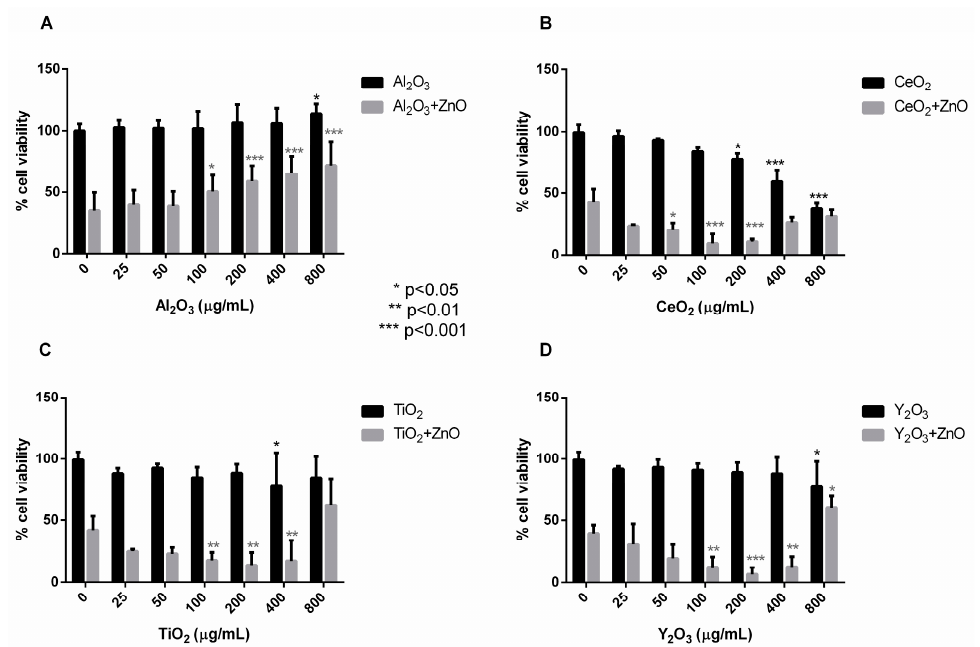
Figure 1. Synergisitc effect on Jurkat cell viability induced by the combination of ZnO with Al 2 O 3 ( A ), CeO 2 ( B ), TiO 2 ( C ) and Y 2 O 3 Nps ( D ). An increase in cell viability was determined by the colorimetric assay Cell Titer 96 ® AQueous One Solution Cell Proliferation Assay for 100–800 µg/mL Al 2 O 3 Nps combined with 60 µg/mL of ZnO and a decrease in viability for the combination of ZnO Nps with CeO 2 , TiO 2 and Y 2 O 3 Nps ( n = 3). In the statistical analysis, the viability of the individual metal oxide Nps at different concentrations were compared to control cells (untreated) and the viability of the metal oxide Np combinations were compared to the viability of ZnO Nps alone. Statistically significant differences are marked with asterisks.